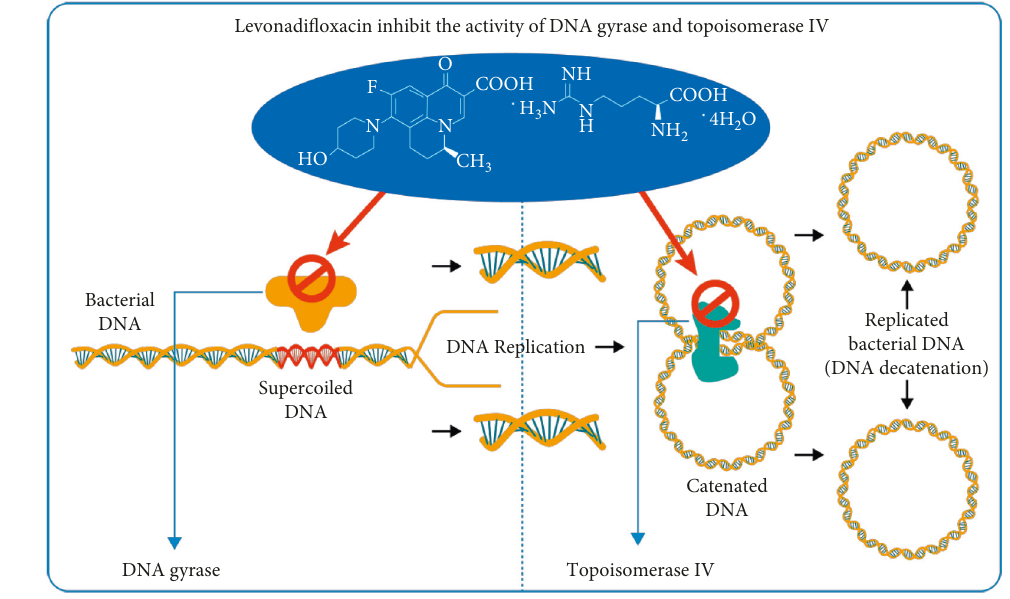
Figure 2: The mechanism of action of levonadifloxacin. Table 3: Unique multispectrum coverage of